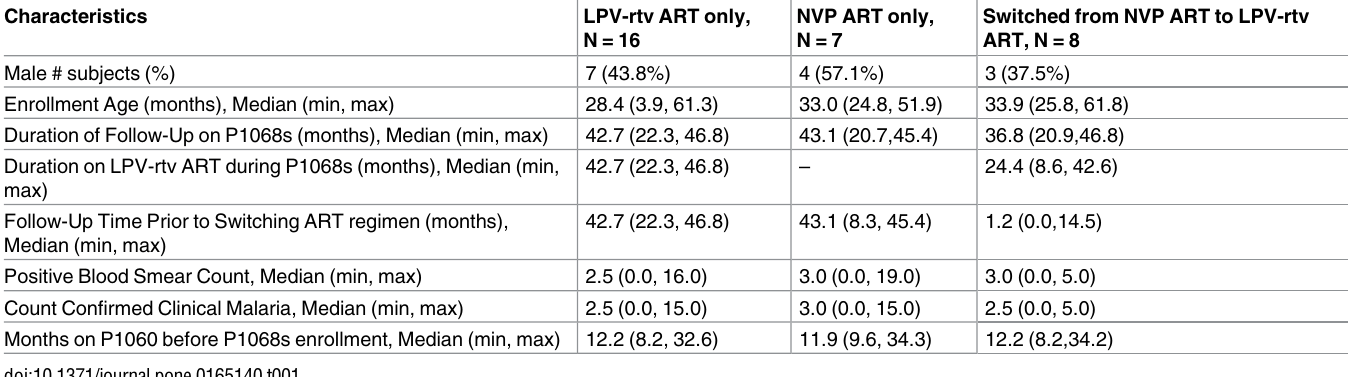
Table 1. Demographic Information for Children Enrolled into P1068sfrom Lilongwe, Malawi.